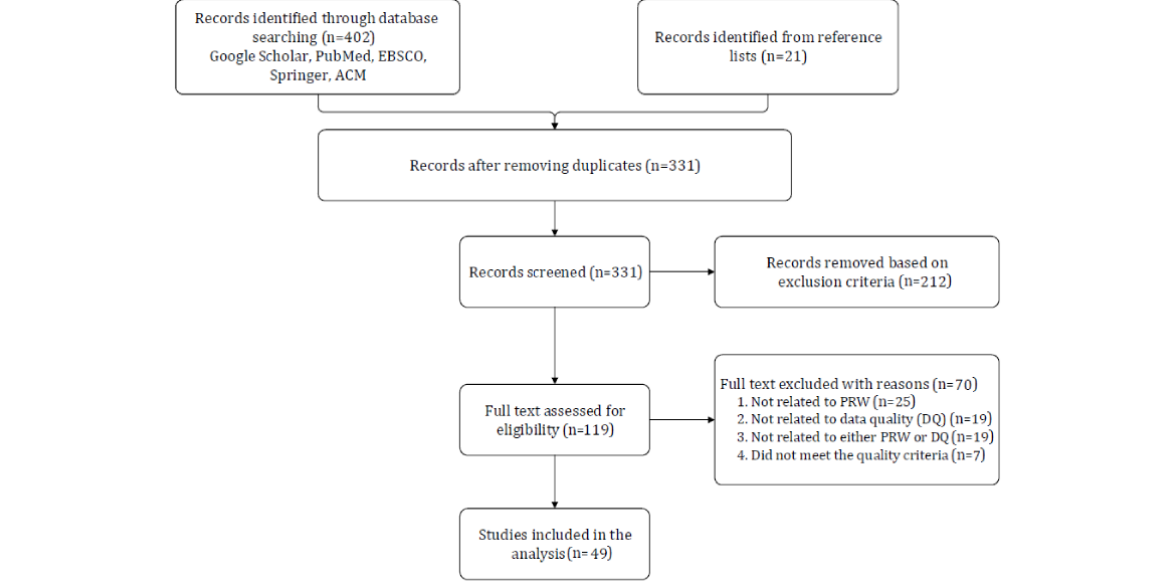
Figure 2. Literature search following the PRISMA guidelines. PRW: physician-rating